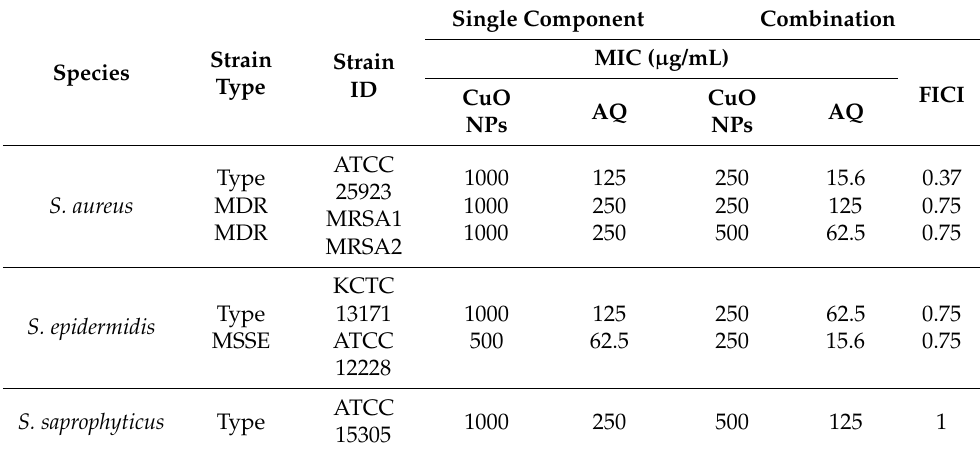
Table 2. MIC and FICI values of CuO NPs, AQ, and their combination against Staphylococcus spp.